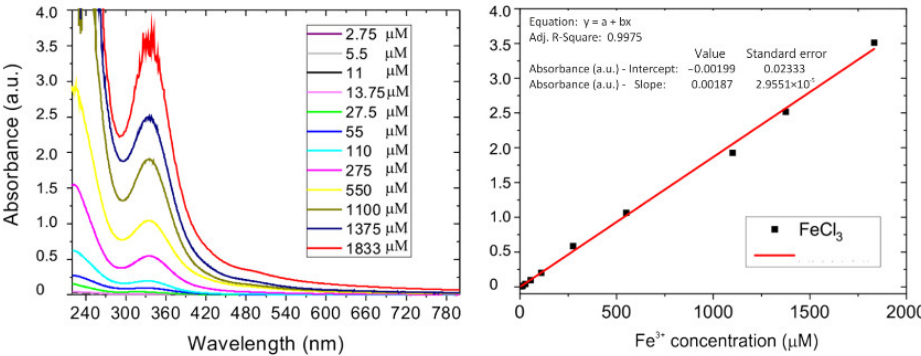
Figure 8. UV-Vis absorbance spectra of FeCl 3 solutions at different concentrations (on the left ); calibration curve of absorbance peak at 334 nm as a function of FeCl 3 concentration (on the right ).